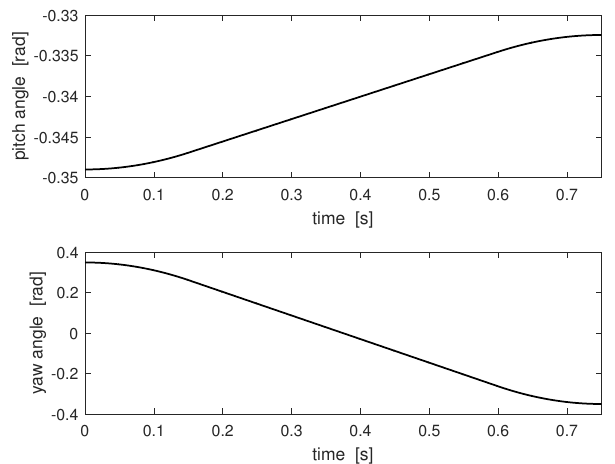
Figure 5. Energy-optimal tool orientation: trapezoidal pitch and yaw